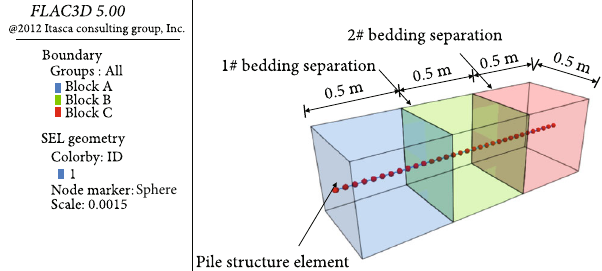
Figure 11: Numerical model diagram with double bedding